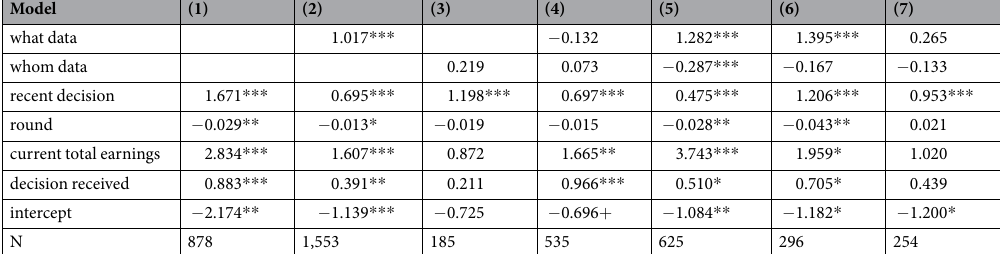
Table 1. Determinants of cooperation. Each column presents estimates of the fit of a logistic generalized linear mixed model to decisions to cooperate (see Supplementary Information). In all models, we controlled the round number, subjects’ current total earnings divided by 10,000, the decisions by subjects in the previous two rounds (the number of ‘C’ between 0 and 2), and previously received help as a recipient in the previous round (‘C’ and ‘D’ are coded as 1 and 0, respectively). Model (2) and Models (4) to (7) consider the average number of items of what data disclosed while Models (3) to (7) consider those of whom data disclosed. Data from the first ten rounds and beyond the 51st round were excluded from the analysis. Data for Model (1) include only those decisions with no disclosure. Models (2) and (3) include those decisions in which only what data and only whom data, respectively, were disclosed. Models (4) and (5) include those decisions in which all pairs are what- prior data and the what data are ‘C’ only and ‘D’ only, respectively. Models (6) and (7) include those decisions in which all pairs are whom-prior data and the whom data are ‘G’ only and ‘B’ only, respectively. The remaining data (N = 1,906) were excluded from the analysis. P-values: *** < 0.1% < ** < 1% < * < 5% < + < 10%, where the P-value is defined as the minimum level of significance that is needed to reject the null hypothesis in relation to each